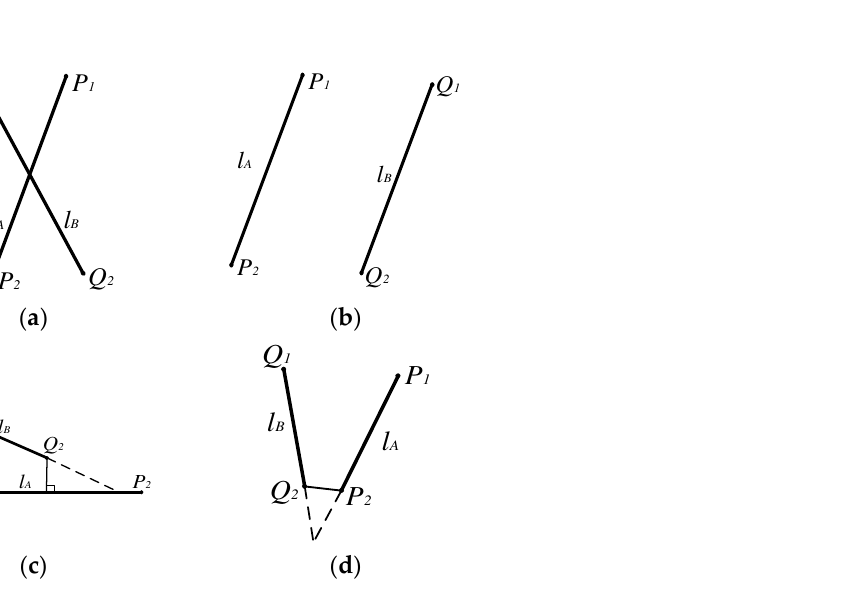
Figure 11. Schematic diagram of the position of the closest point between the line segments. ( a ) intersecting line segments ( b ) Parallel line segments ( c ) Contour segment ( d ) Contour segment. If